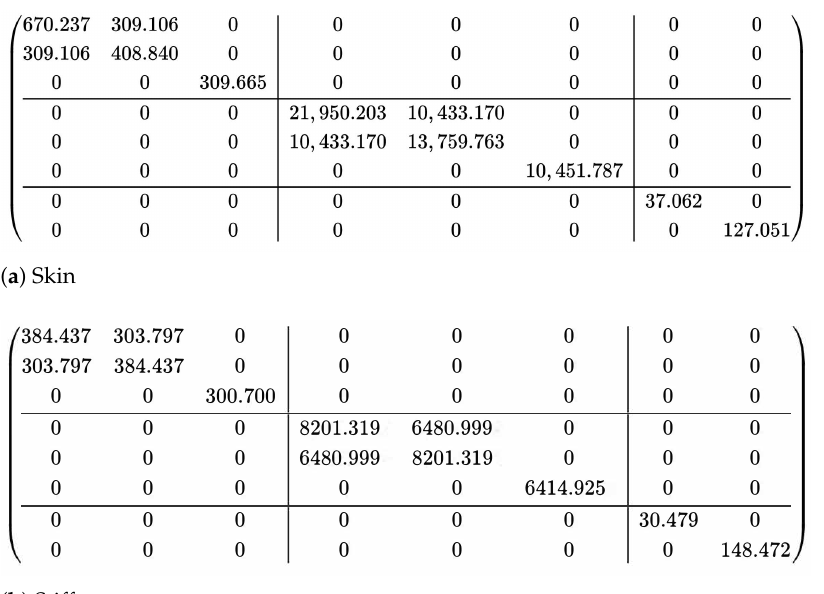
Figure 5. Effective plate properties of the skin and the stiffener calculated by the present model (unit: